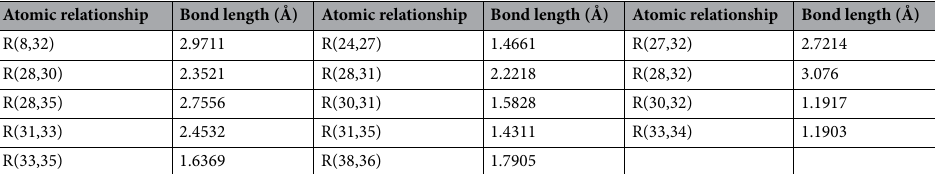
Table 2. Bond lengths of three NO 2 molecules on the coal surface side chain adsorption equilibrium configuration.